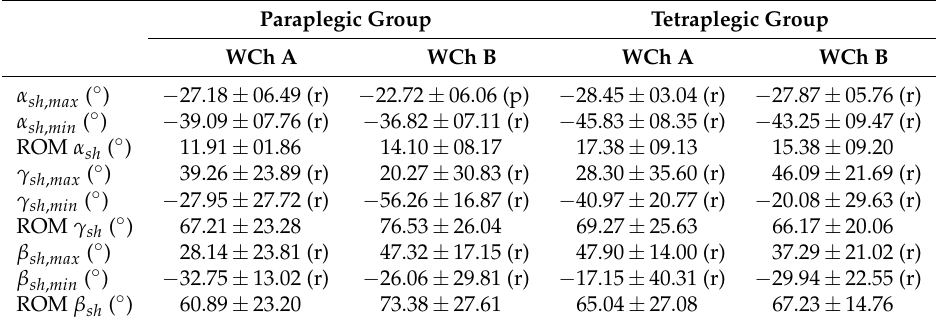
Table 9. Kinematic variables on the shoulder: maximum, minimum and ROM values (mean ± SD) and the propulsion phase in which they happen: pushing (p) or recovery phase